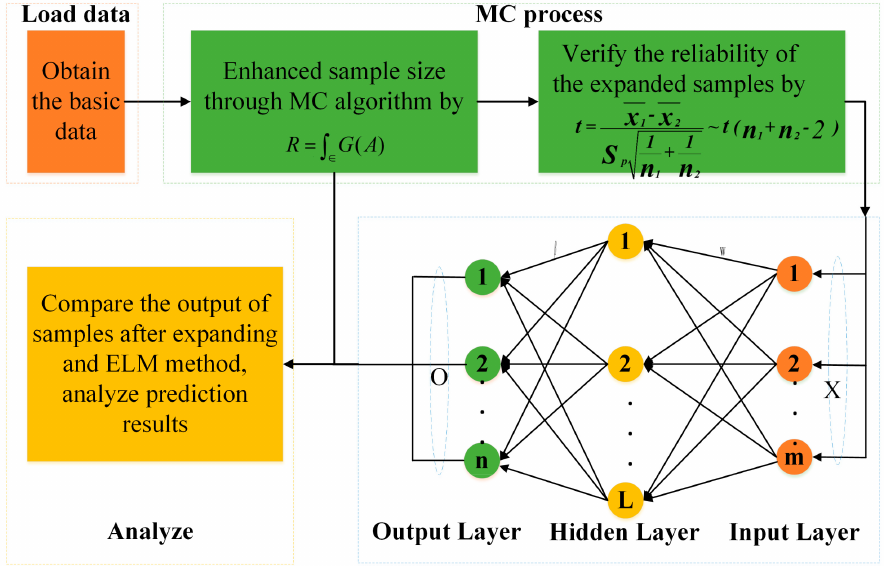
Figure 2. The flow of Monte Carlo integrating extreme learning machine